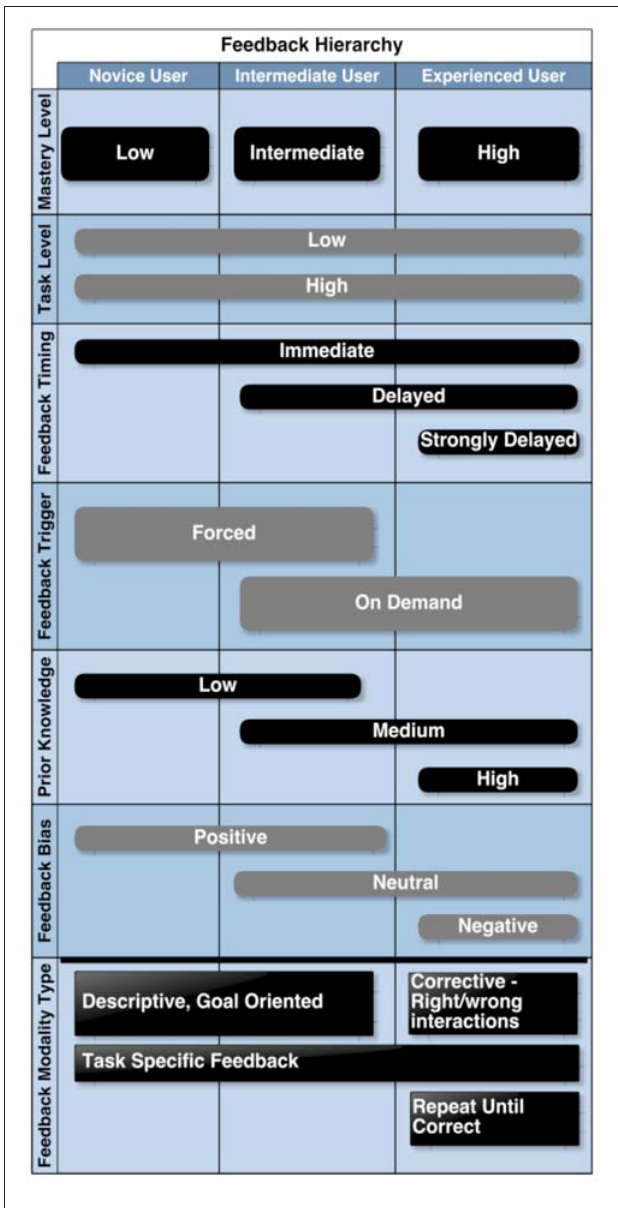
FIGURE 3 | A hierarchy of feedback modalities and types for BCIs from Kosmyna (2015). Figure is reproduced with permission from the copyright